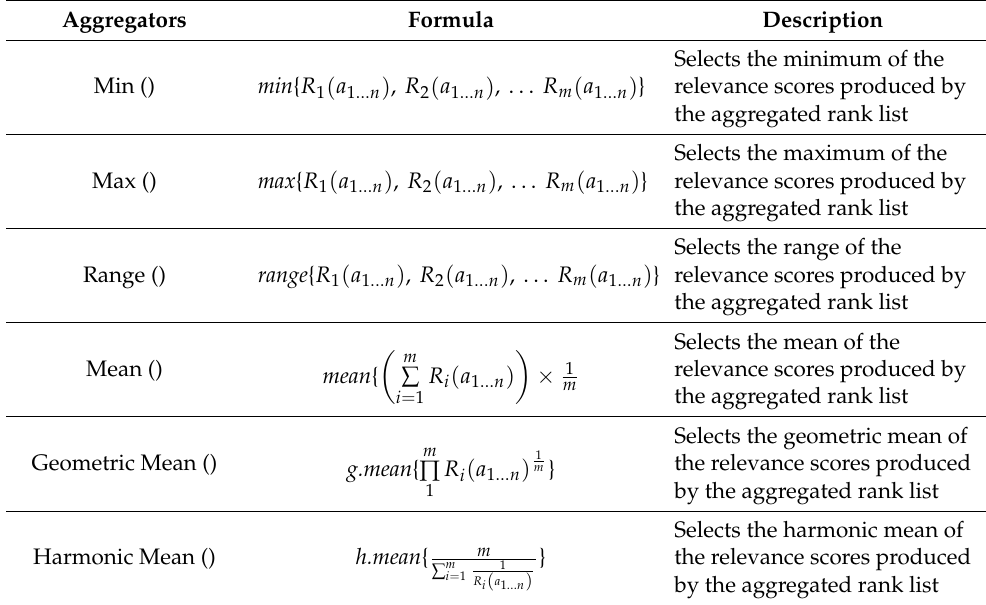
Table 2. Rank Aggregation